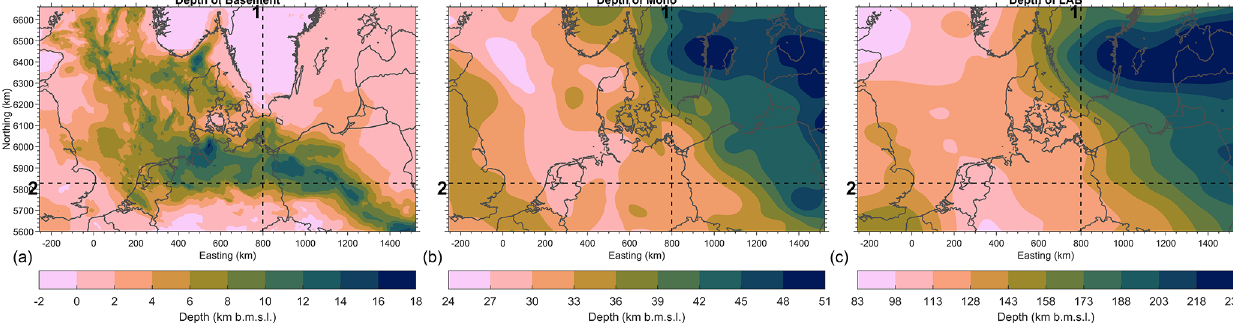
Figure A1. Base depth maps of the main geological discontinuity in the 3-D model of the CEBS. From left to right: depth to the basement; depth to the Moho crust–mantle boundary; and depth to the lithosphere–asthenosphere boundary (LAB); the latter was also used to impose the bottom boundary isothermal condition. Also shown in all figures are the locations of the profiles shown in Fig.